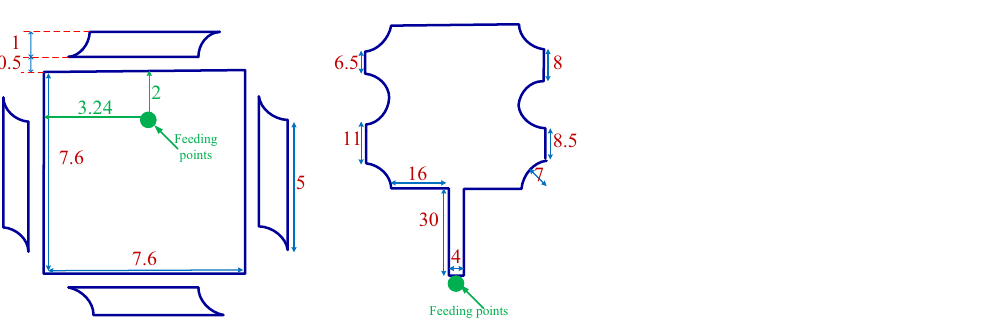
Figure 4. Flowchart of our proposed method.